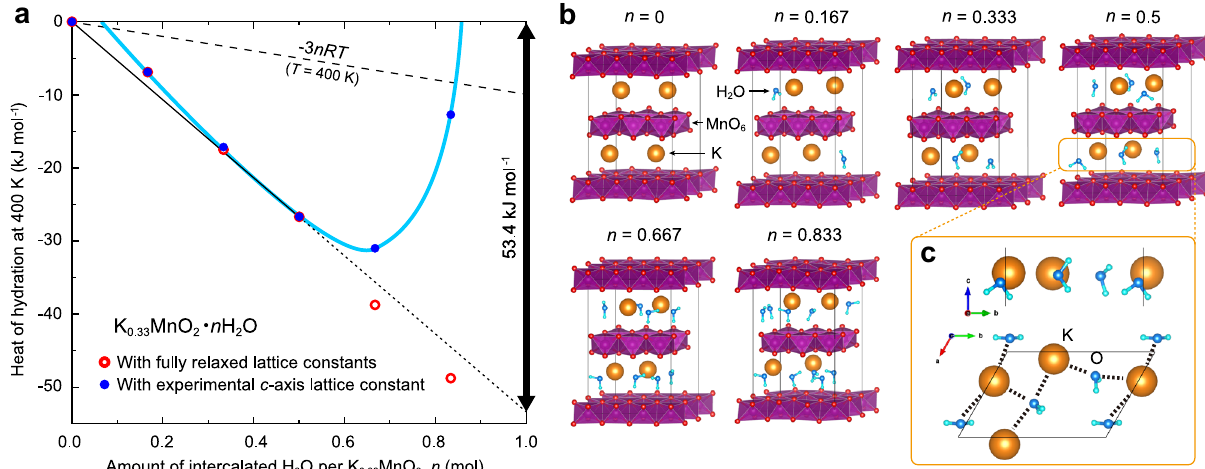
Fig. 3 Ab initio calculations of hydration heat and optimized structure of δ -K 0.33 MnO 2 ∙ n H 2 O. a Heat of hydration (enthalpy bene fi t due to the water intercalation) obtained by ab initio calculation for δ -K 0.33 MnO 2 ⋅ n H 2 O, b the optimized structure with H 2 O molecules for each content of water. c A typical coordination of K + ions and H 2 O molecules sited in an interlayer for n = 0.5, where the averaged distances of K-O(H 2 O) and K-H are 2.83 Å and 2.97 Å, respectively. The internal energy of H 2 O gas ( = 3 nRT ) is considered by assuming that H 2 O is an ideal gas with degree of freedom 3 (translational) + 3 (rotation). The two sets, free relaxed (red) and fi xed lattice constants (blue), are